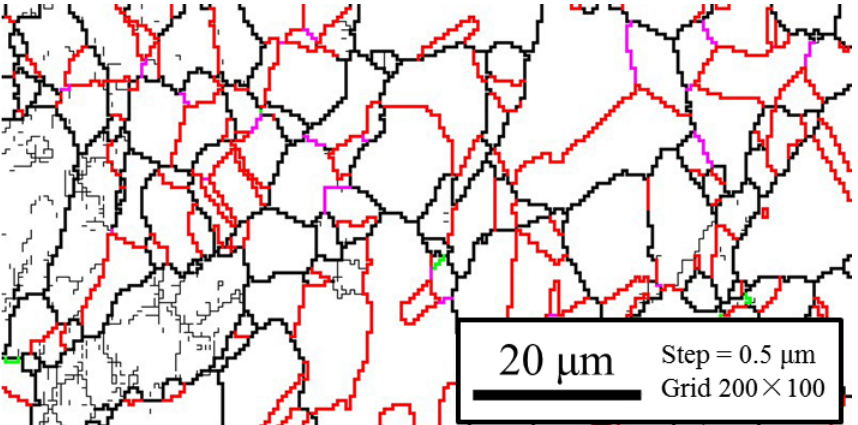
Figure 3. Initial microstructure of specimen: thin black lines represent the low angle grain boundary; thick black lines represent the high angle grain boundary; red, pink, green lines represent Σ 3, Σ 9, Σ 27, twin boundaries respectively.